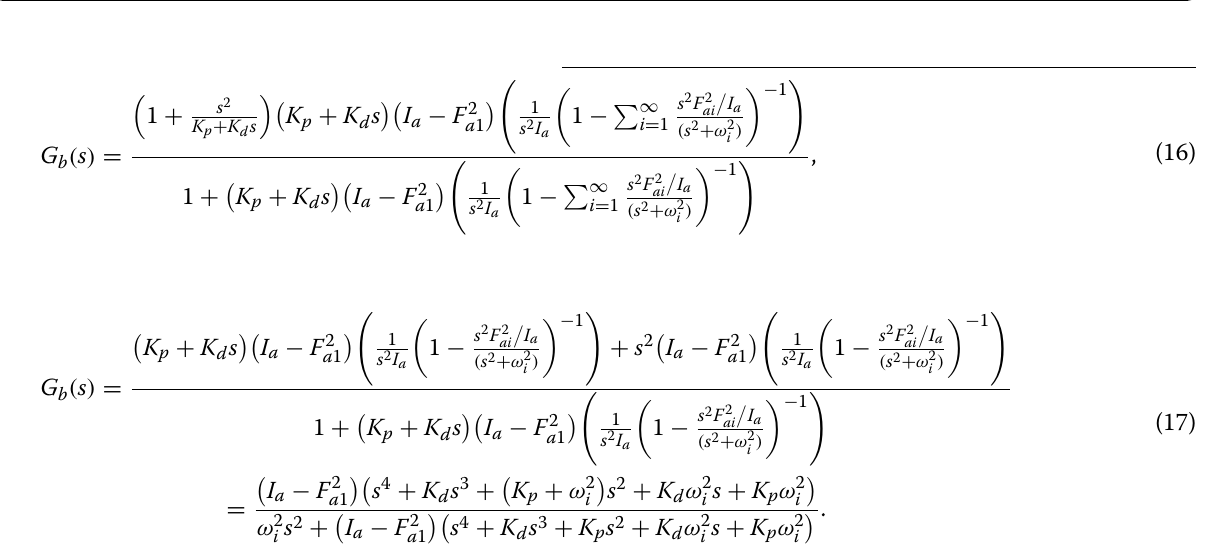
Figure 7 Distribution diagram of evaluation indexes: ( a ) Maximum overshoot, ( b ) Peak time, ( c ) Adjust